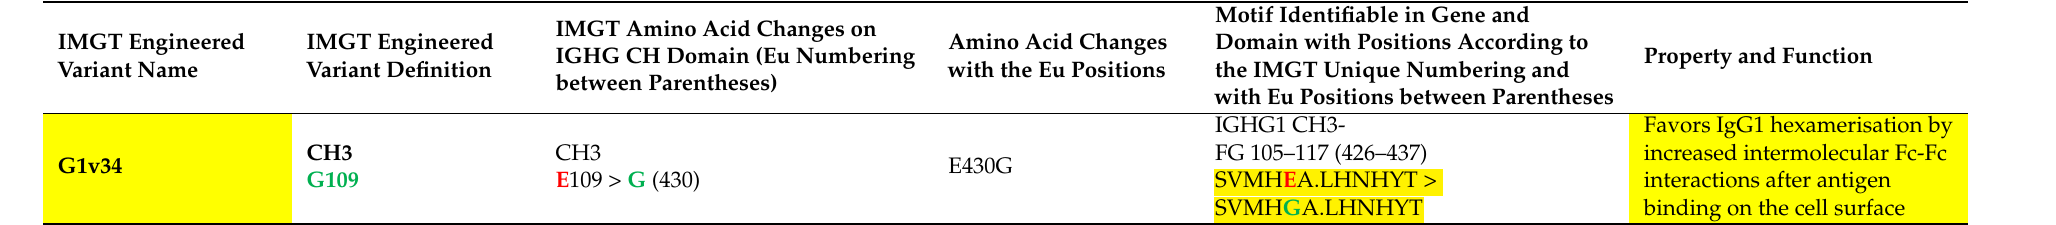
Table 17. IMGT nomenclature, Eu positions and IMGT motif of engineered Fc variants involved in hexamerisation (Structure